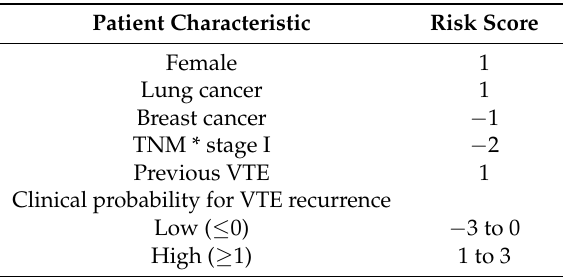
Table 2. Ottawa Score for recurrent VTE risk in cancer-associated